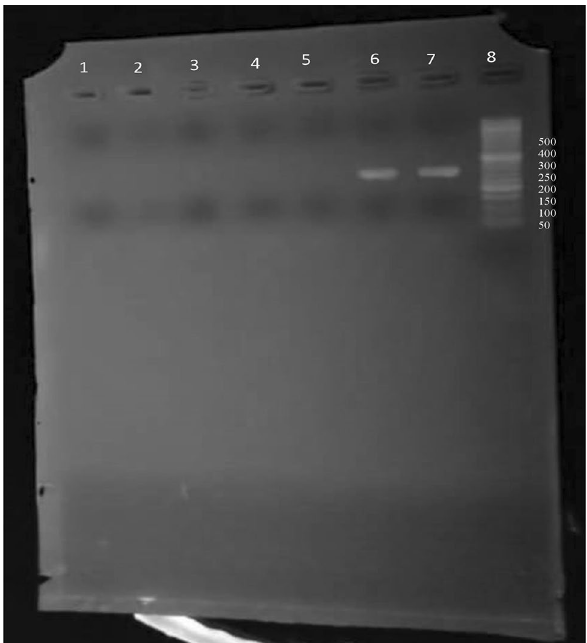
Figure 3. Gel electrophoresis showing the amplified product of the mcr-1 gene (309 bp). Lanes 1–4: negative isolates; Lane 5: negative control; Lane 6: positive control (band size 309 bp); Lane 7: mcr-1 positive isolate; Lane 8: 50 bp DNA ladder (50 bp-1500 bp) (Cleaver Scientific,